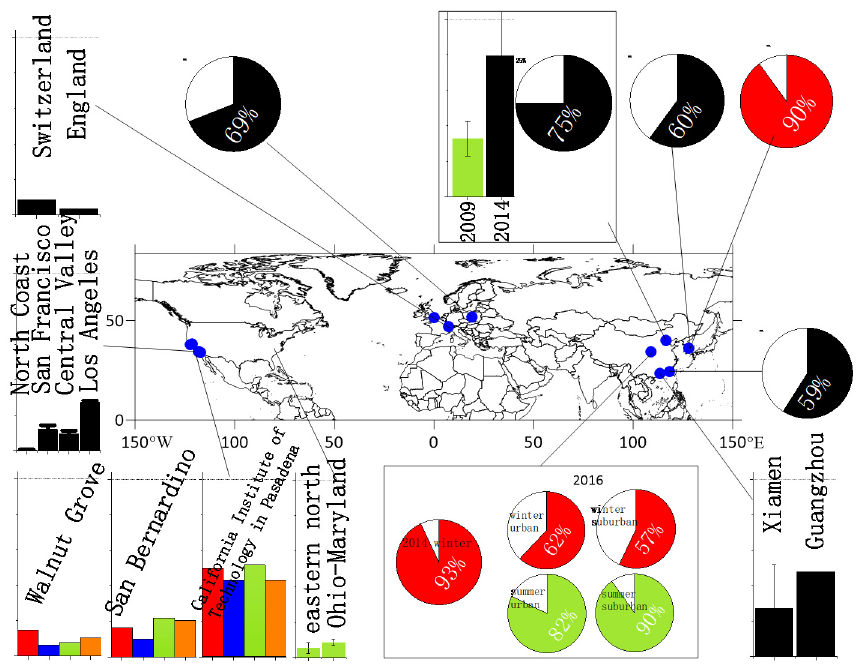
Figure 3. The spatial distribution of ∆ 14 CO 2 traced FFCO 2 . The percentage in pie charts represents the fossil fuel component to total CO 2 . The grid lines in histograms represent that the FFCO 2 value is 50 ppm. Colors in pie charts and histograms: blue-spring, green-summer, orange-autumn, red-winter, black- yearly values